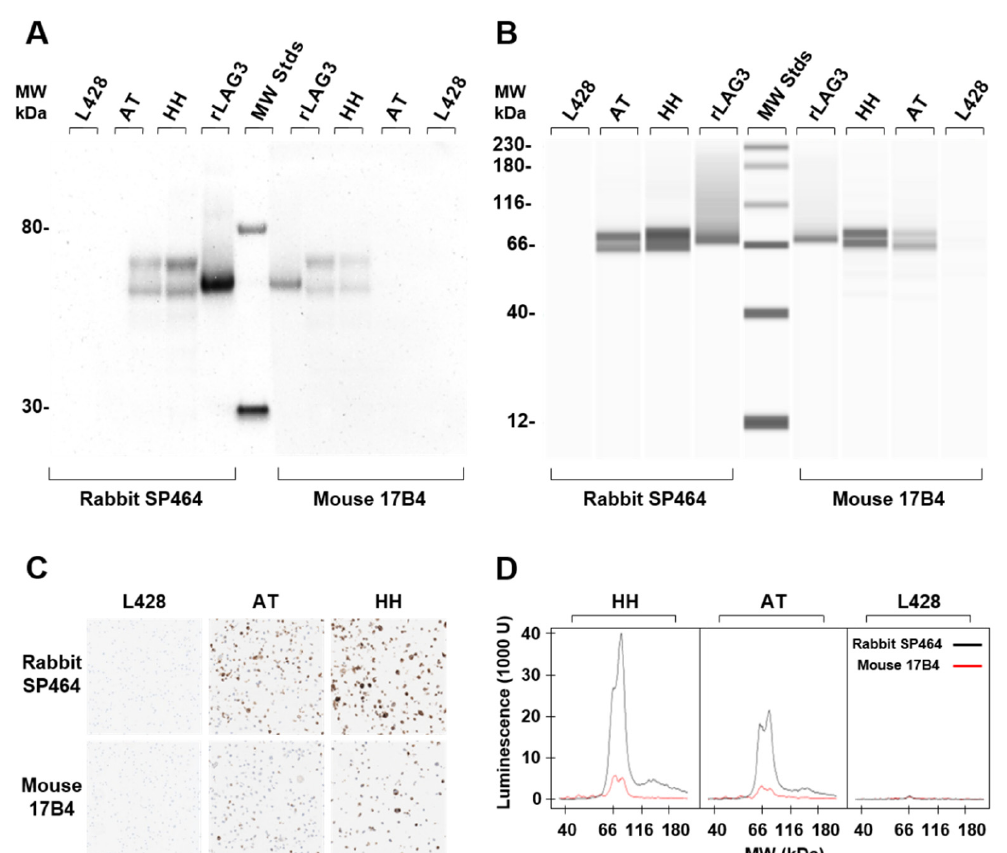
Figure 1. Comparison of rabbit monoclonal antibody SP464 with mouse monoclonal antibody 17B4. Western blot analysis ( A ) and ACE analysis ( B ) of recombinant LAG3 and cell line lysates probed with SP464 or 17B4. The contrast of the lanes containing recombinant LAG3 in panel B have been reduced to discern the position of the recombinant LAG3 band from the smear due to protein overload in the capillaries. Both Western blot and ACE identify two species of LAG3 protein, the full length (~58 kDa) and the soluble form (~52 kDa), in the AT and HH cell line lysates. ( C ) IHC using SP464 (upper panels) and mouse 17B4 (lower panels) to stain the cell lines L428 (negative), AT (low expresser), and HH (high expresser). ( D ) Luminescence signal intensity of cell line lysates separated by ACE and detected with SP464 (black line) and 17B4 (red line).